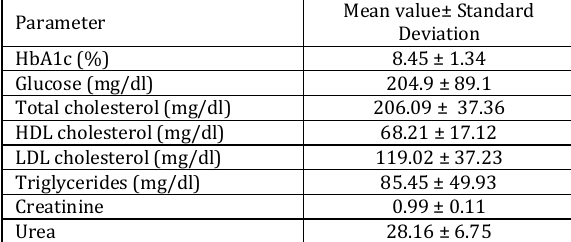
Table I. Mean results of laboratory tests in examined group